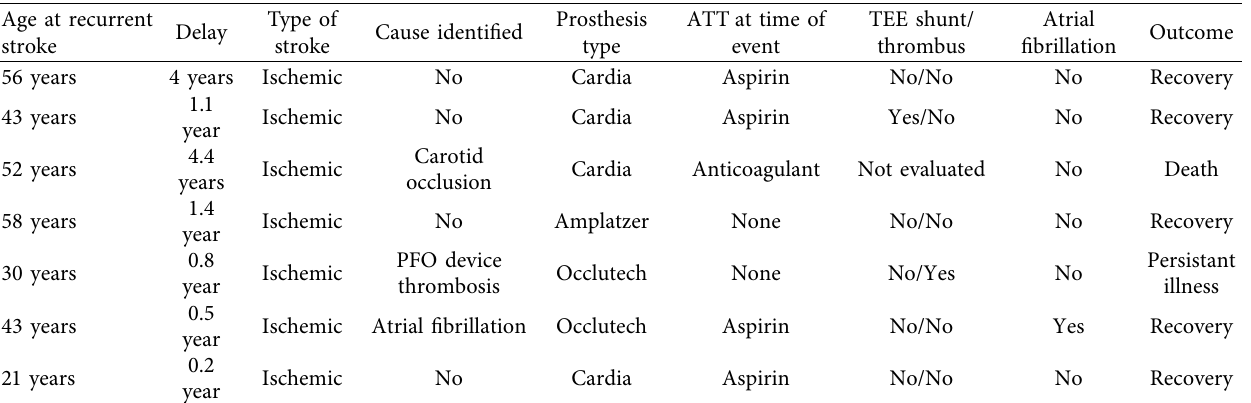
Table 4: Details of recurrent